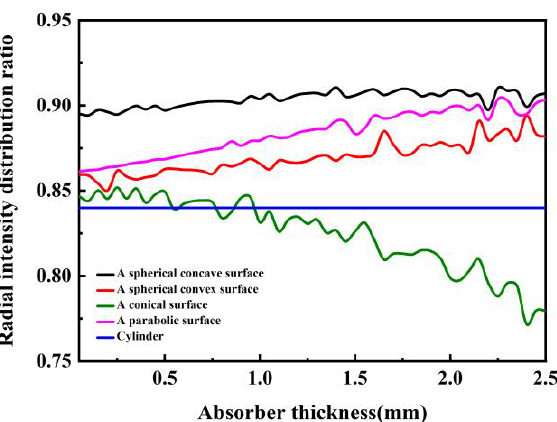
Figure 6. Radial intensity distribution ratio of the laser output using 5 different kinds of saturated absorbers.